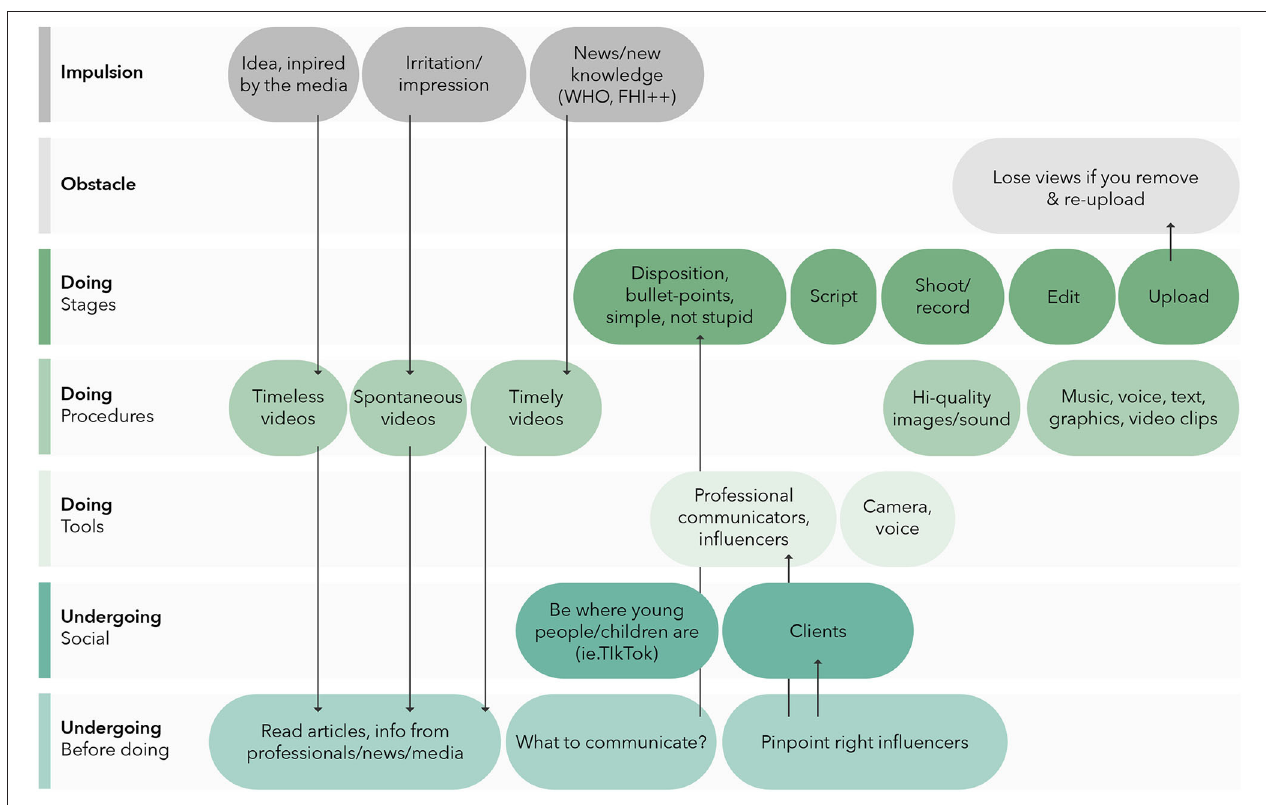
FIGURE 7 | A flow chart representation of creative activity as explained by SoMe/YouTube